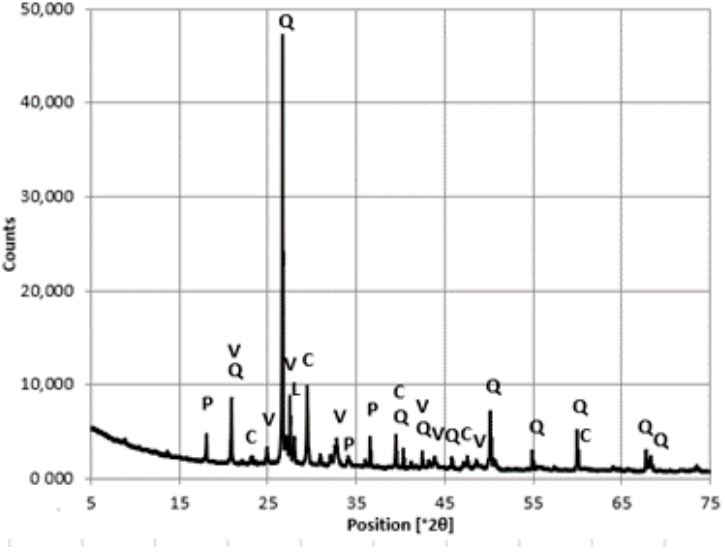
Figure 16. A diffractogram of the cement slurry from the concrete samples, top floor slab layer. Designation: P—portlandite, V—vaterite, A—aragonite, C—calcite, Q—quartz, L—larnite.